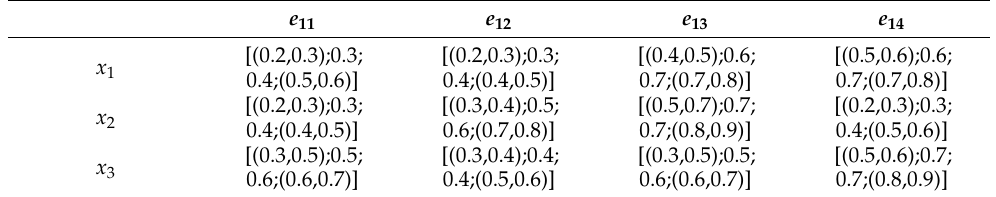
Table A2. The different risk evaluation values subordinated by influencing factors of B 1 at time t 1 .